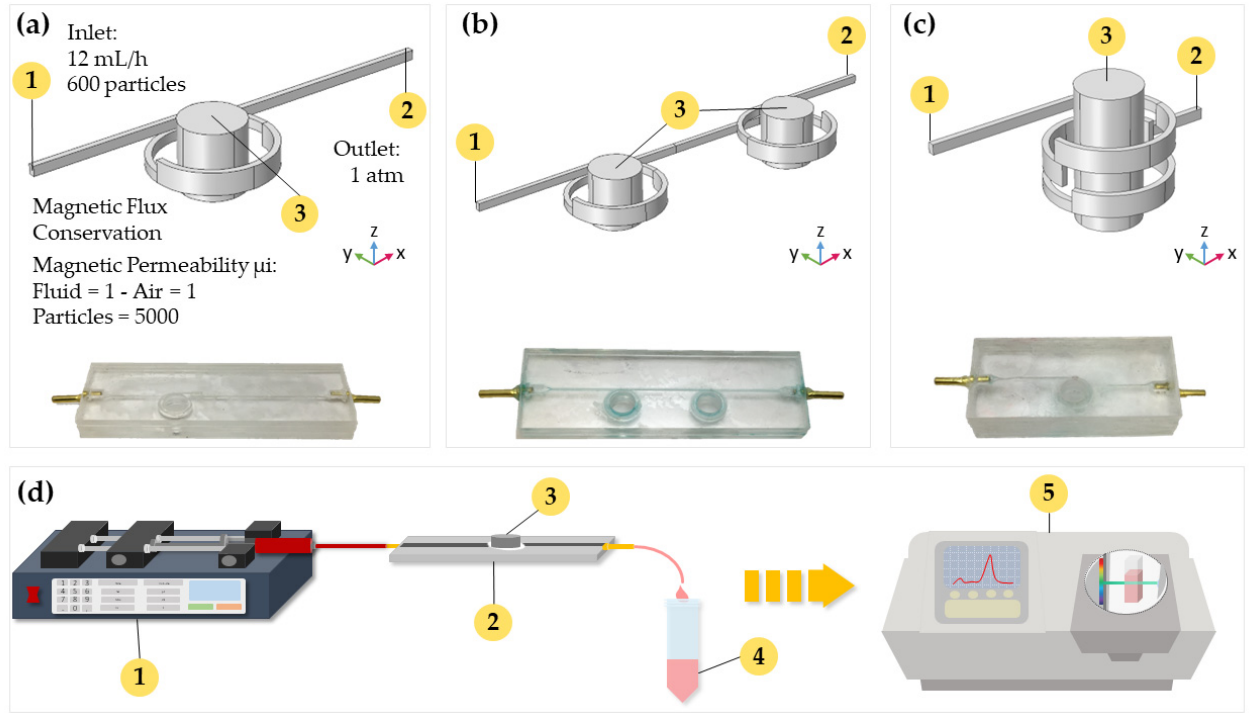
Figure 1. ( a ) Simulation geometry and actual picture of one-loop microreactor. ( b ) Simulation ge- ometry and actual picture of the two-horizontal-microreactor. ( c ) Simulation geometry and actual picture of the two-vertical-loop microreactor. ( d ) Schematic of the experimental setup for the biotrans- formation process. The numbers 1, 2, 3, 4, and 5 in the figure correspond to the solution injection, microreactor, permanent magnet, treated sample, and absorbance analysis, respectively.